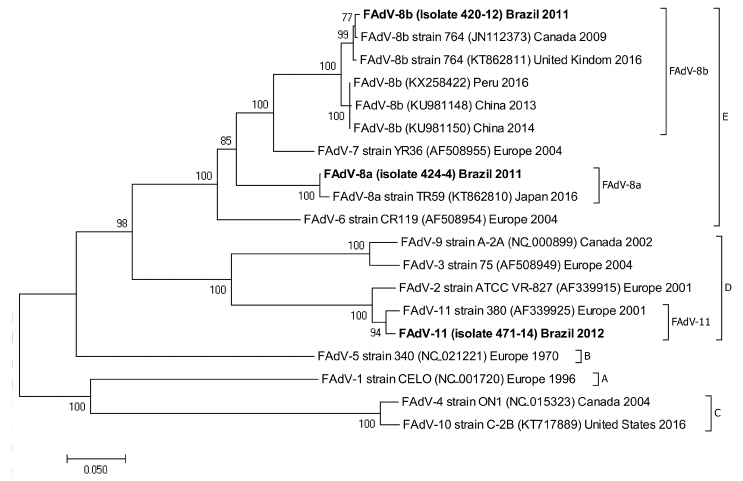
Figure 1. Phylogenetic tree for FAdV-I strains, was inferred with the neighbor-joining statistical method and based on the partial sequence of the Hexon gene. Numbers along the branches refer to bootstrap values for 1000 replicates. The five species of FAdV-I are grouped and identified with letters A–E. Isolate 424-4 was clustered with the reference sequence of strain TR59 with a bootstrap value of 100 in the common ancestral line, suggesting that this isolate should be classified into the FAdV-8a serotype. Isolate 420-12 was clustered with reference sequences of strain 764, and some isolates originated from China and Peru, with a bootstrap value of 100 in the common ancestor of the 6 sequences, suggesting that this isolate should be classified as FAdV-8b serotype. Isolate 471-14 clustered with the reference sequence of strain ATCC, suggesting that this isolate should be classified as FAdV-11 serotype. Isolates 475-5, 656-3, 691-6, and 752-3, clustered with reference sequences of Avian Nephritis Virus from the United States, Korea, Australia, China, and Japan, and a second group of isolates (541-2, 541-12, and 541-16) were clustered with reference sequences of chicken astrovirus from India and the United States, showing high bootstrap values for each group of both types of astroviruses detected in this study (Figure 2).